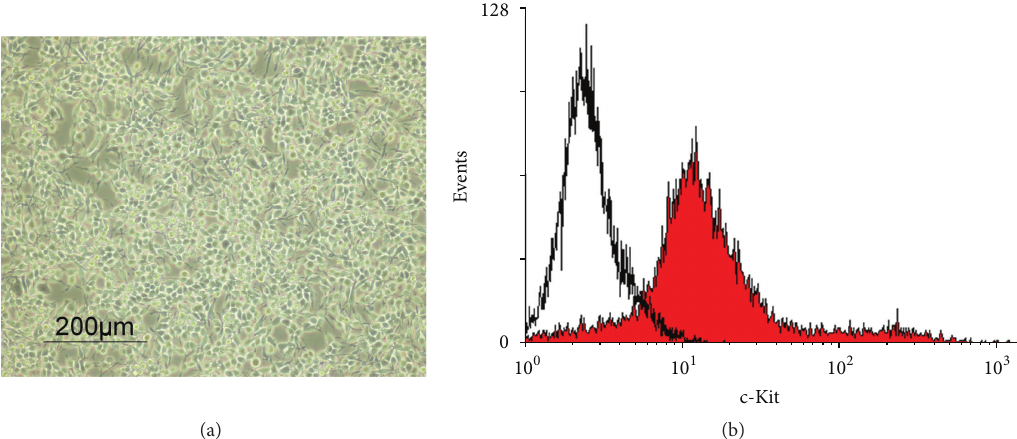
Figure 2: Purity analysis of RBL-2H3. (a) The morphology of RBL-2H3 cells was examined by phase-contrast photomicrography. (b) Cellular expression of c-Kit was analyzed by flow cytometric analysis. Line, isotype antibody control; solid, anti-c-Kit antibody.